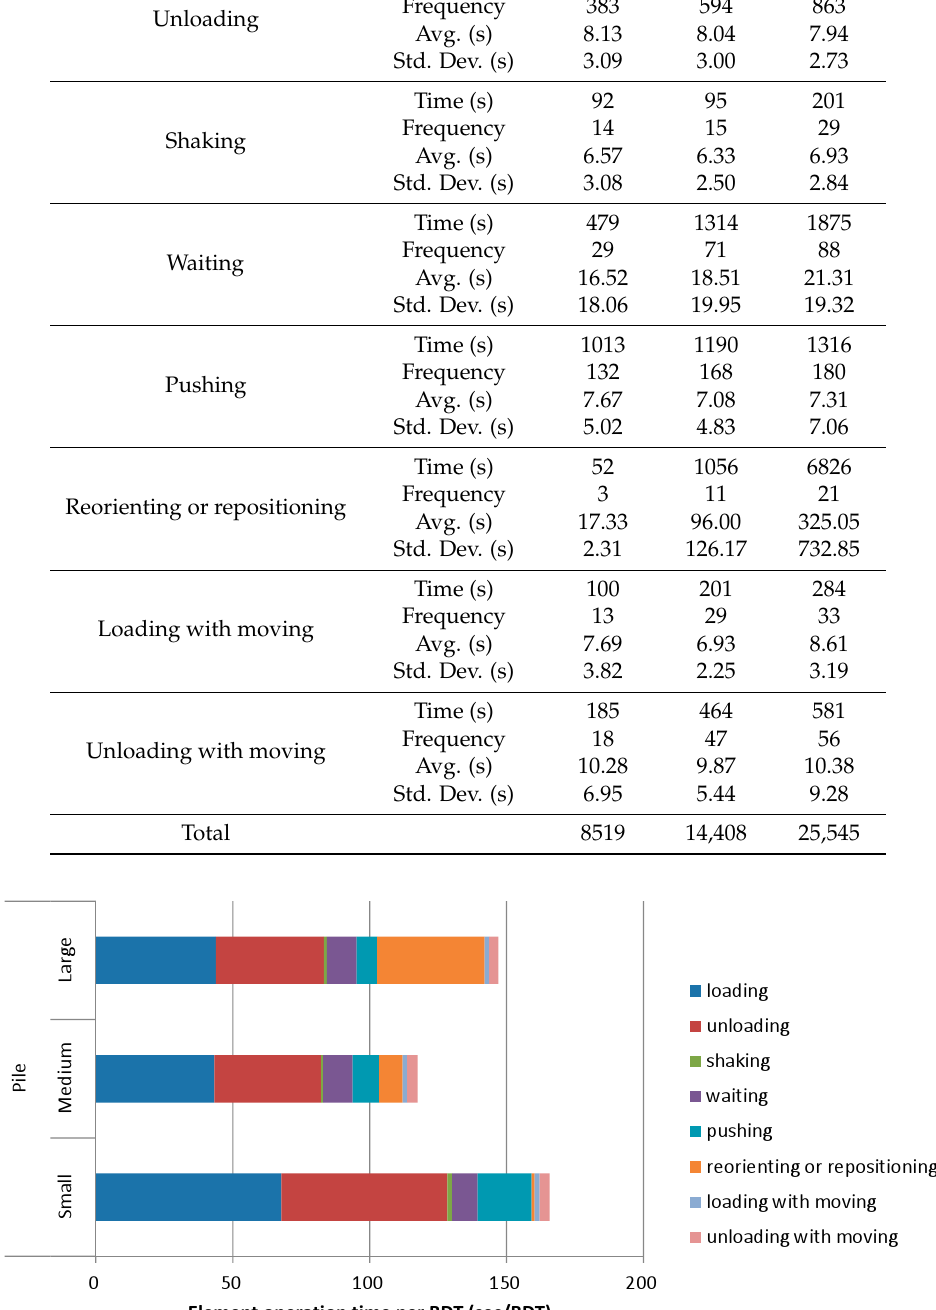
Figure 4. Element operation time per BDT.